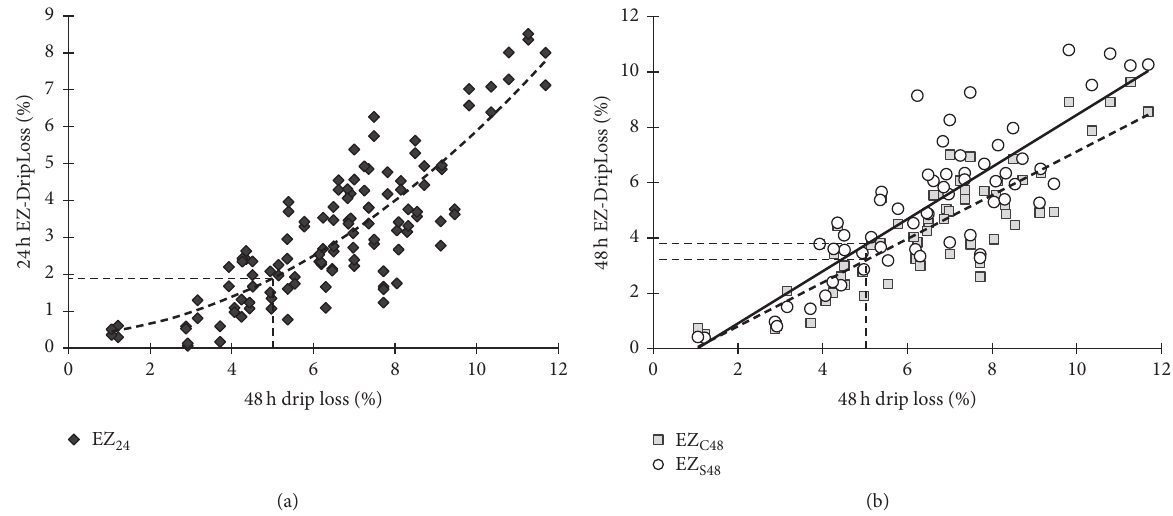
Figure 2: Regressions of 24 h (EZ 24 ) and 48 h, dabbed (EZ C 48 ) and nondabbed (EZ S 48 ) EZ-DripLoss as a function of 48 h drip loss by the bag method (DL) in pork loins ( 𝑛 = 60 ). EZ 24 , % = 0.33 + 0.07 × DL + 0.05 × DL 2 ± 1.02% (SE), 𝑅 2 = 0.72, and 𝑃 < 0.0001 ; EZ C 48 , % = − 0.78 + 0.79 × DL ± 1.10% (SE), 𝑅 2 = 0.74, and 𝑃 < 0.0001 ; and EZ S 48 , % = − 0.98 + 0.94 × DL ± 1.41% (SE), 𝑅 2 = 0.70, and 𝑃 < 0.0001